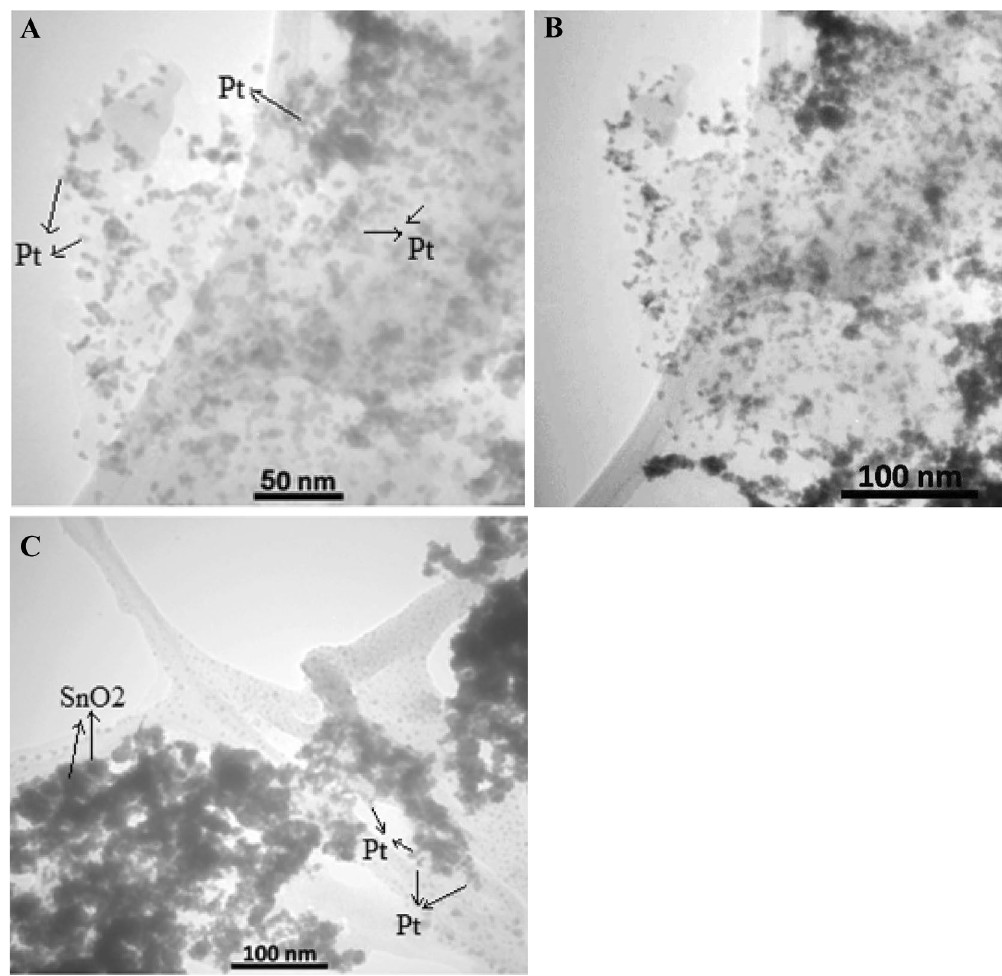
Figure 2. TEM images of ( A ), ( B ) Pt/Bnt-mRGO-CH and ( C ) Pt-SnO 2 /Bnt-mRGO-CH nanocatalysts.